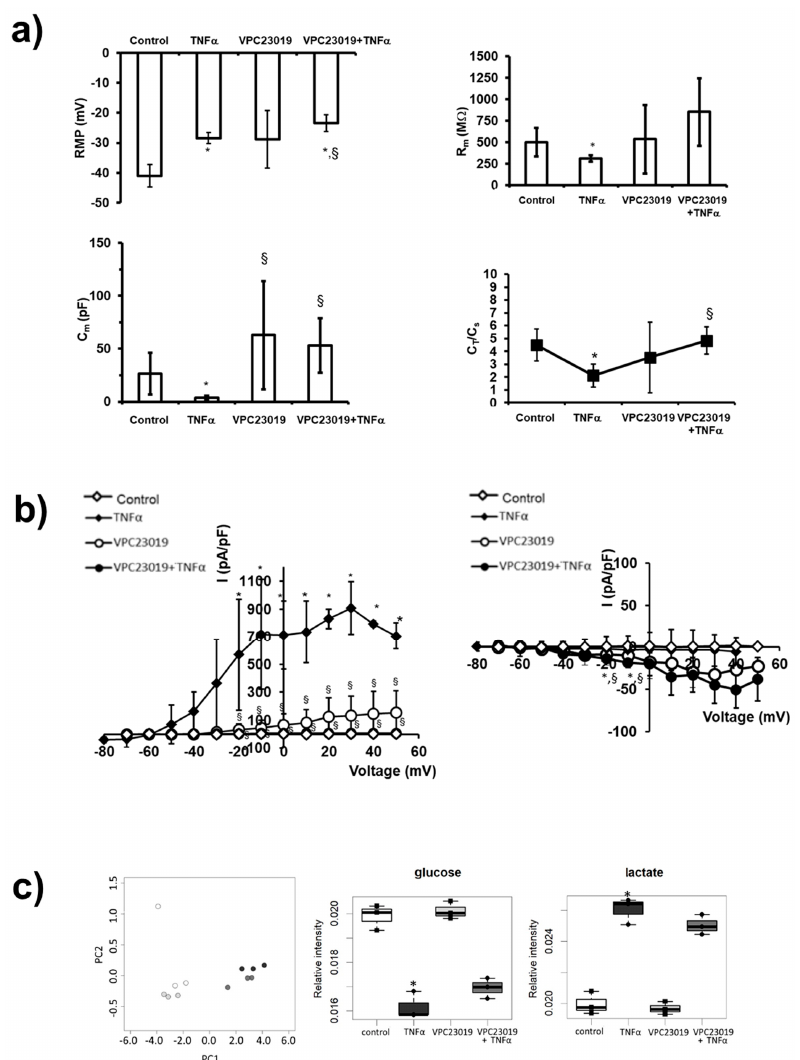
Figure 6. Role of S1P 3 in TNF α -induced effect in C2C12 myotubes. ( a ) RMP, R m , C m and C T /C s ratio in the different conditions. All of the results and number of cells investigated are listed in Table S1 as mean ± SD. * Indicates p < 0.05 vs. control; § indicates p < 0.05 vs. TNF α ; (One-way ANOVA and Bonferroni’s post hoc test). ( b ) Left panel: overall I-V plots related to K + currents measured in all the experiments conducted in any conditions. * p < 0.05 vs. control, § p < 0.05 VPC23019 + TNF α vs. TNF α (two-way ANOVA and Bonferroni’s post hoc test) ( n = 3 to 7 for the different treatments). Right panel: Overall I–V plots related to Ca 2+ currents measured in all the experiments conducted in any conditions ( n = 3 to 7 for the different treatments). * p < 0.05 vs. control; § p < 0.05 vs. TNF α (two-way ANOVA and Bonferroni’s post hoc test). Error bars are shown when their size is bigger than the symbol. ( c ) Left panel: Metabolomic phenotyping of conditioned media (exo-metabolome). Score plots of PCA: PC1 vs. PC2. In the score plots, each dot represents a different sample, and each colour represents a different group of samples—white: control; dark grey: TNF α ; light grey: VPC23019; medium grey: VPC23019+TNF α . Right panels: boxplot of the metabolites involved in glycolysis. Changes in metabolite levels caused by TNF α were statistically significant by paired Wilcoxon test, (* p <